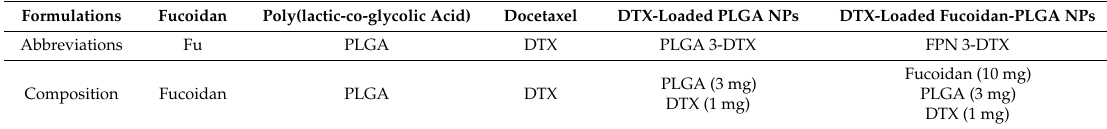
Table 1. Abbreviations and composition of all